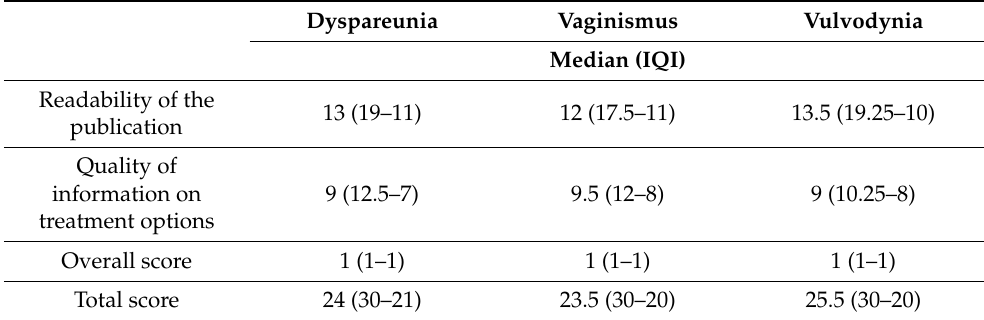
Table 1. Distribution of scores obtained for information quality, overall and by health condition, according to the DISCERN questionnaire.